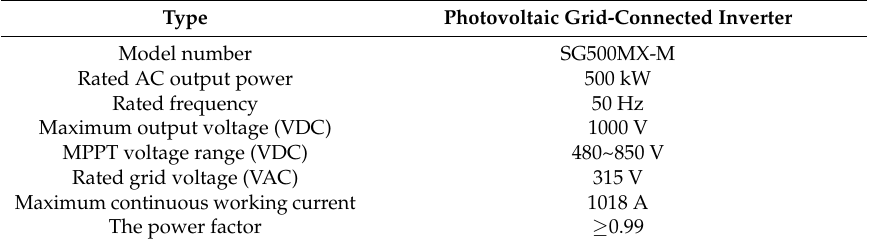
Table A1. Basic parameters of PV generator set.